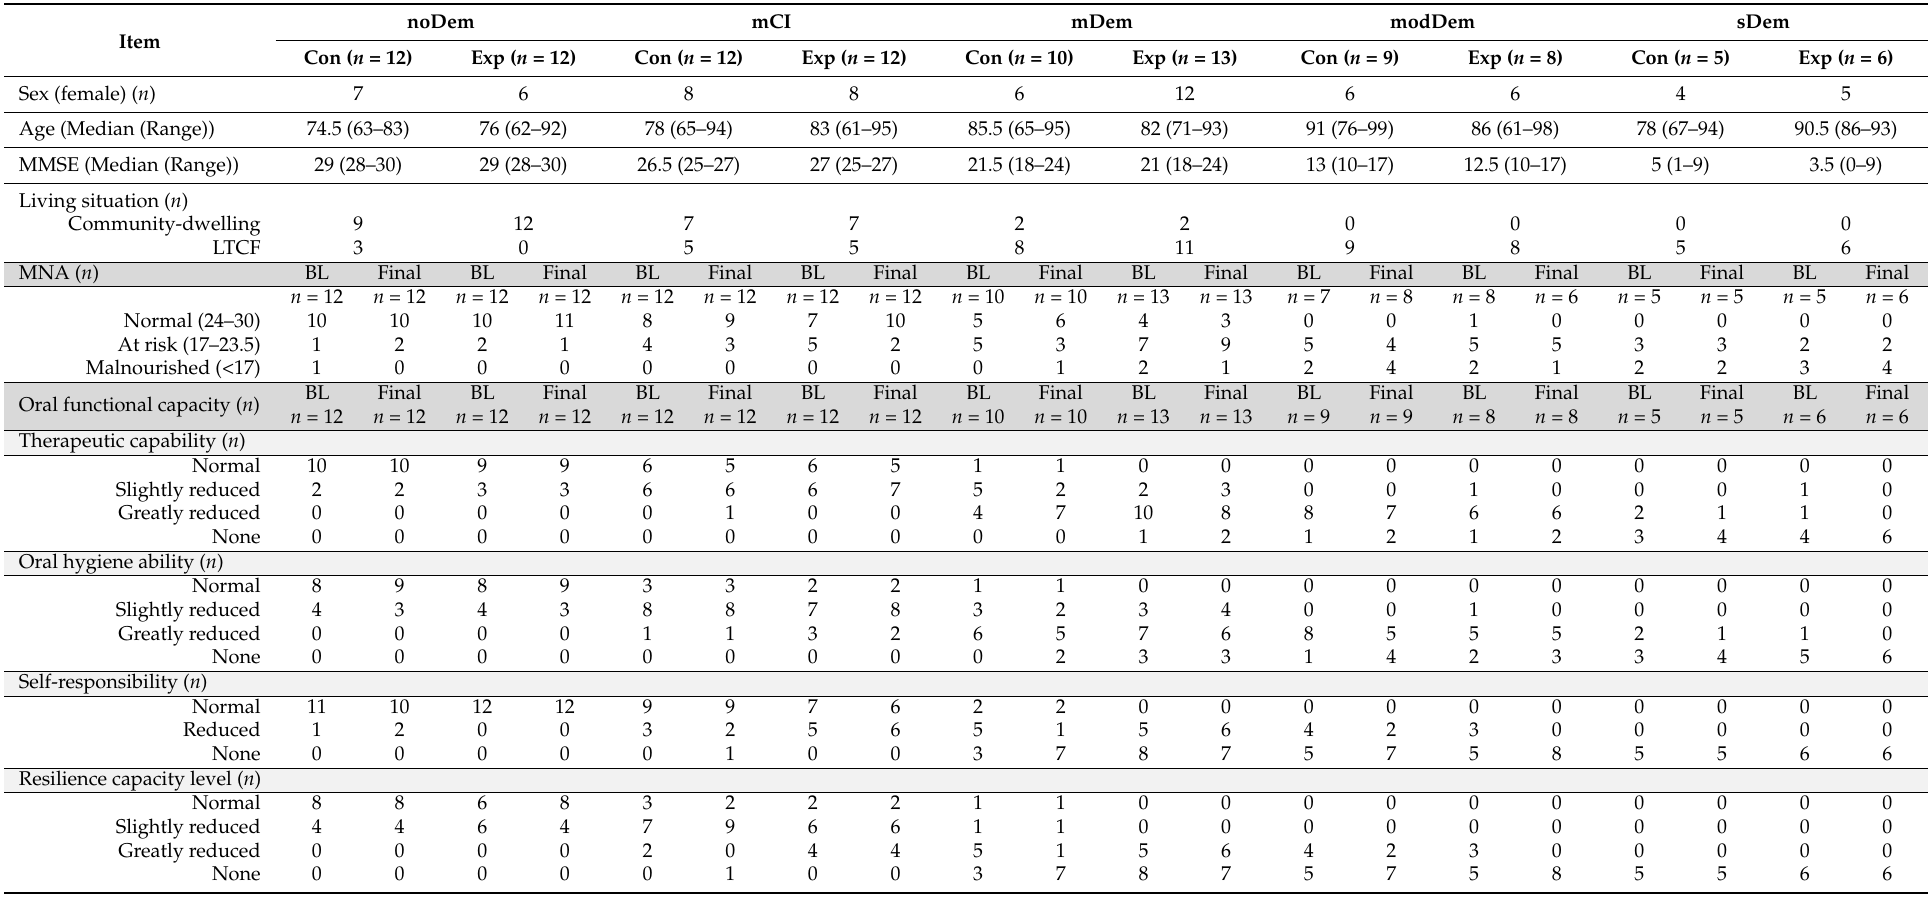
Table 1. Sociodemographic data (age, gender, living situation), mini mental state examination (MMSE), data on nutritional status (MNA: mini nutritional assessment) and oral functional capacity (OFC), its parameters: therapeutic capability, oral hygiene ability, and self-responsibility, and the resulting resilience capacity level (RCL) (evaluation time point—BL: baseline; Final (12 months after BL)) (Exp: experimental group; Con: control group) (MMSE groups—noDem: no dementia; mCI: